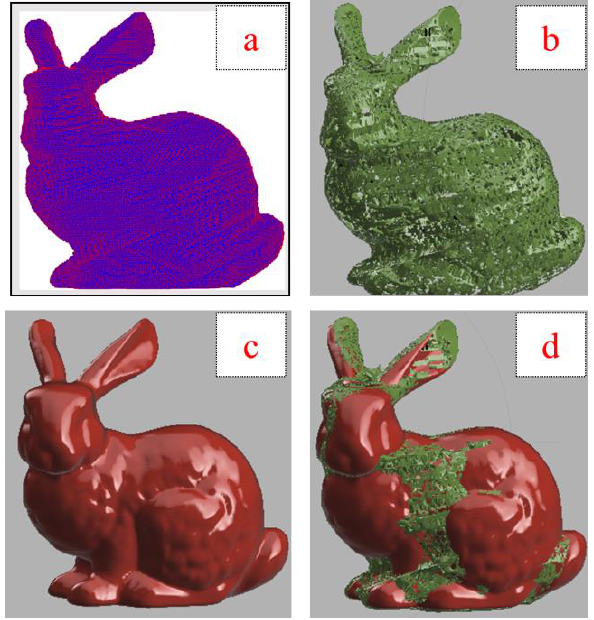
Figure 16. Comparison of the reconstruction and ground-truth model. Figures (a-d) show the reconstructed voxel-based modelled, mesh model, ground-truth model, and superimposed models,